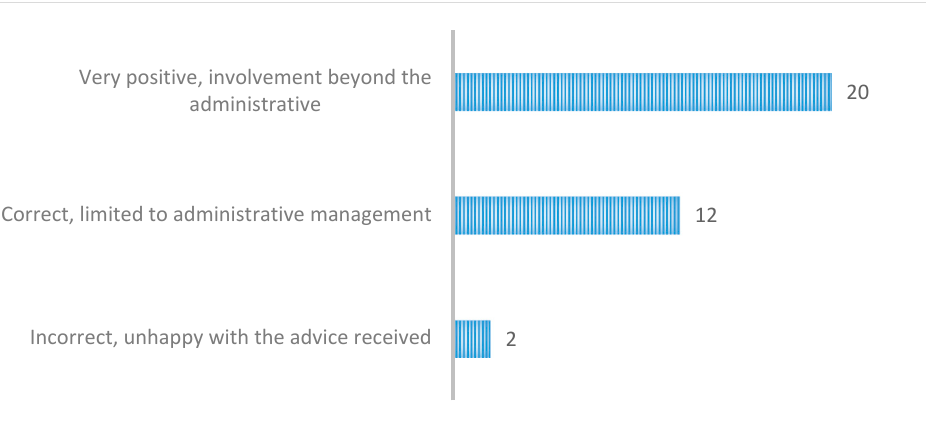
Figure 4. Do you think Proder has contributed to the economic diversification of the region? Through which sectors? Source: Own elaboration . Closely linked to the multi-sectorial approach, the dissemination effect refers to the capacity of development programs to ensure that the investments made serve as an example and enable other entrepreneurs to undertake new projects. The existence of this dissemination effect is widely perceived by the promoters. It is even significant that most of the interviewees responded positively to the question posed (Figure 5), even though they were not able to give any examples.